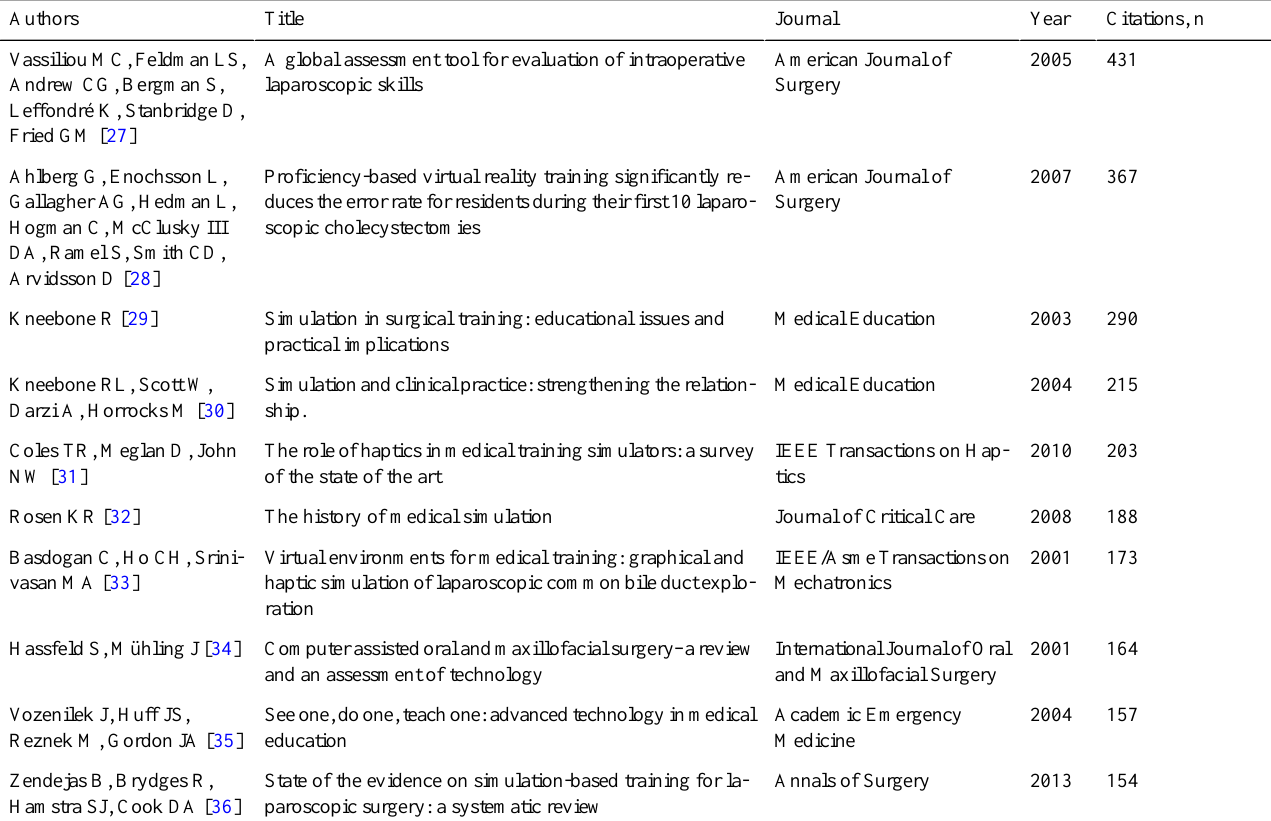
Table 7. The 10 most cited papers with simulation as their keyword.